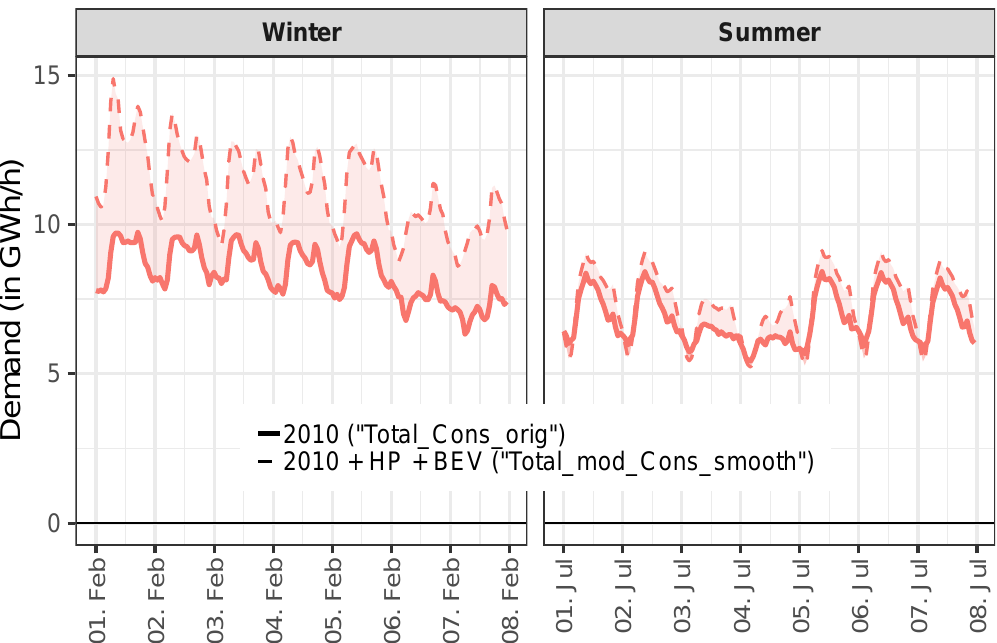
Figure 17. Comparison of the hourly total electricity demand for the original (“Total_Cons_orig” in Table 1) and modified profile (with heat pumps and BEV; “Total_mod_Cons_smooth” in Table 1) in a randomly selected week in winter and summer. Differences are the red shaded